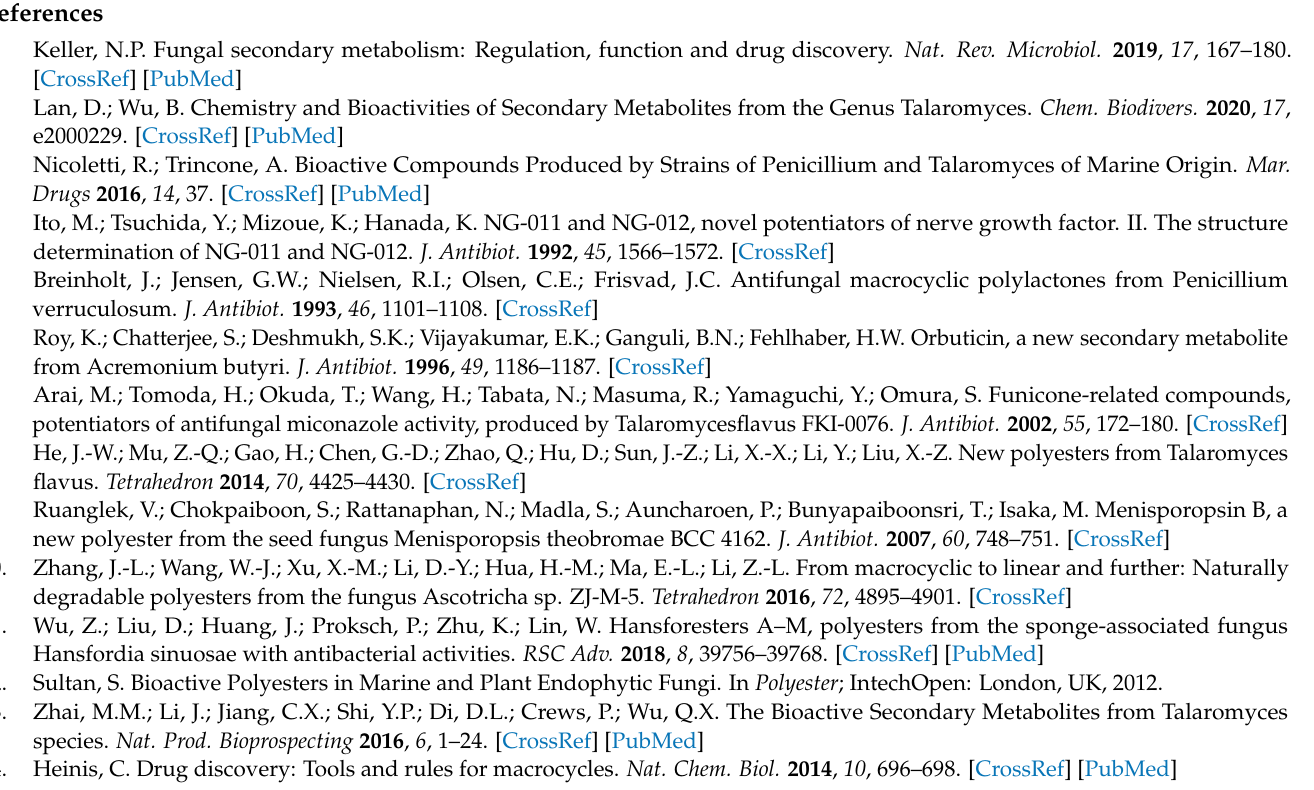
Figure S12: The result of protein Blast searches of Men1 and Men2 amino acid sequences against Talaromyces stipitatus protein database; Figures S13 and S14; The domains analysis of TpeA and TpeB using SMART tool; Figure S15: The indication for inactive DH domain of TpeA; Tables S1–S2; The similarity of TpeA and TpeB domains to their counterparts in Men1 and